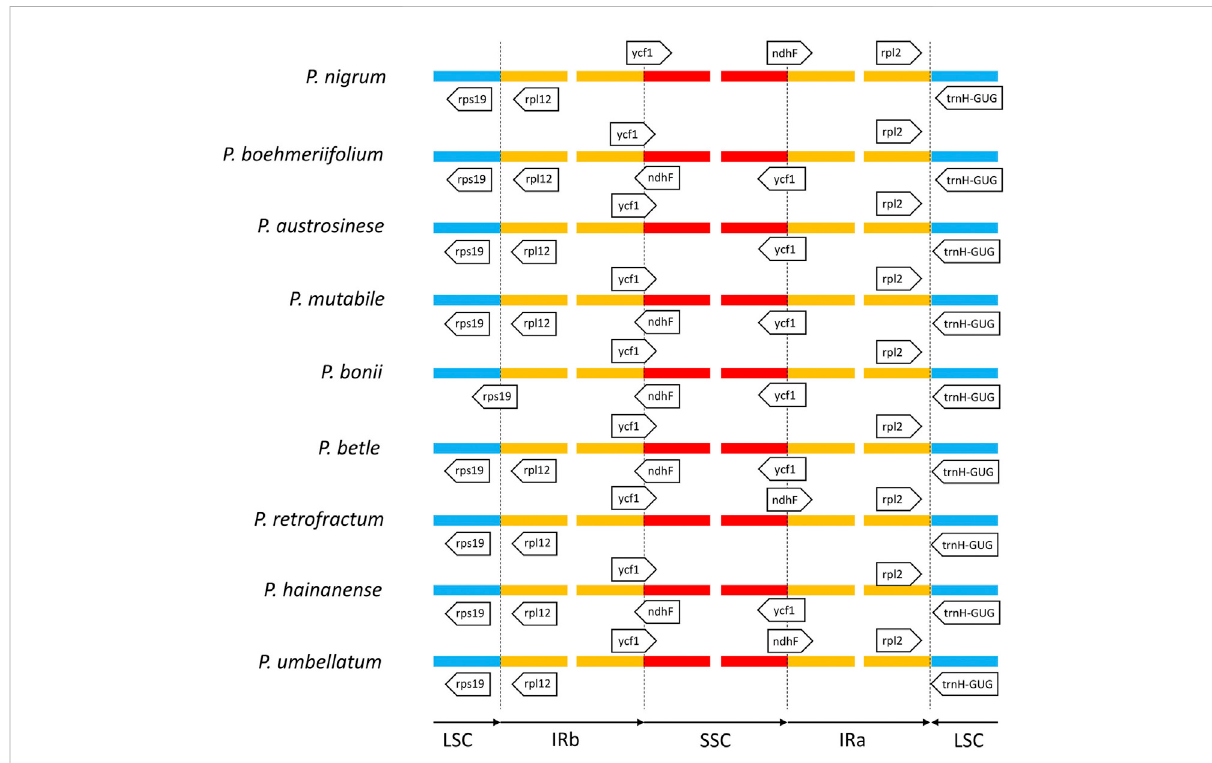
FIGURE 7 Comparison of boundaries among IR, LSC, and SSC regions of nine Piper species. Genes above lines are transcribed forward and those below the lines are transcribed